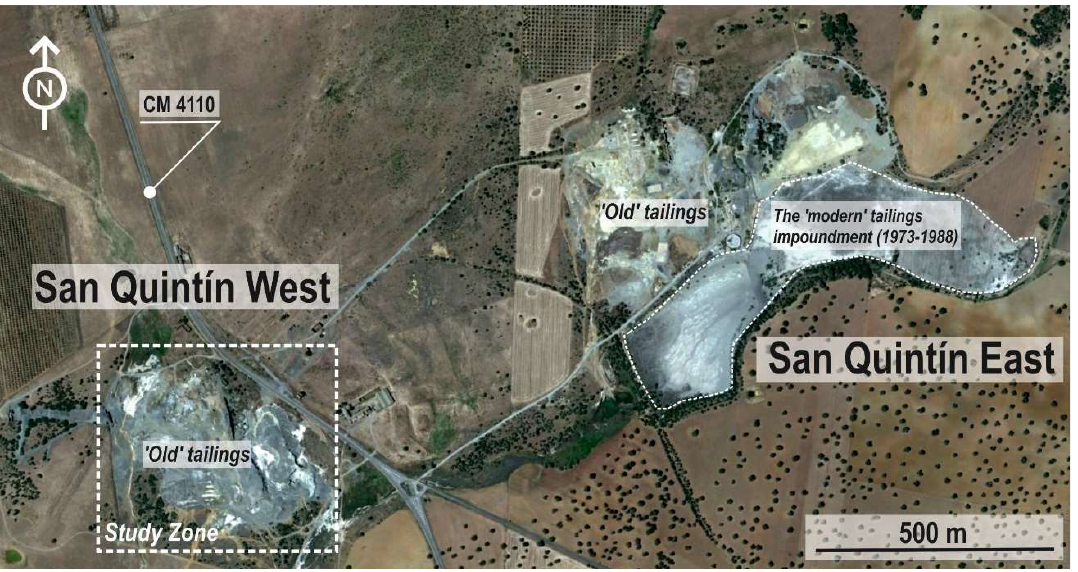
Figure 2. San Quintín East and West depicting location of the “older” (1888–1923) and “modern” tailings (1973–1988).